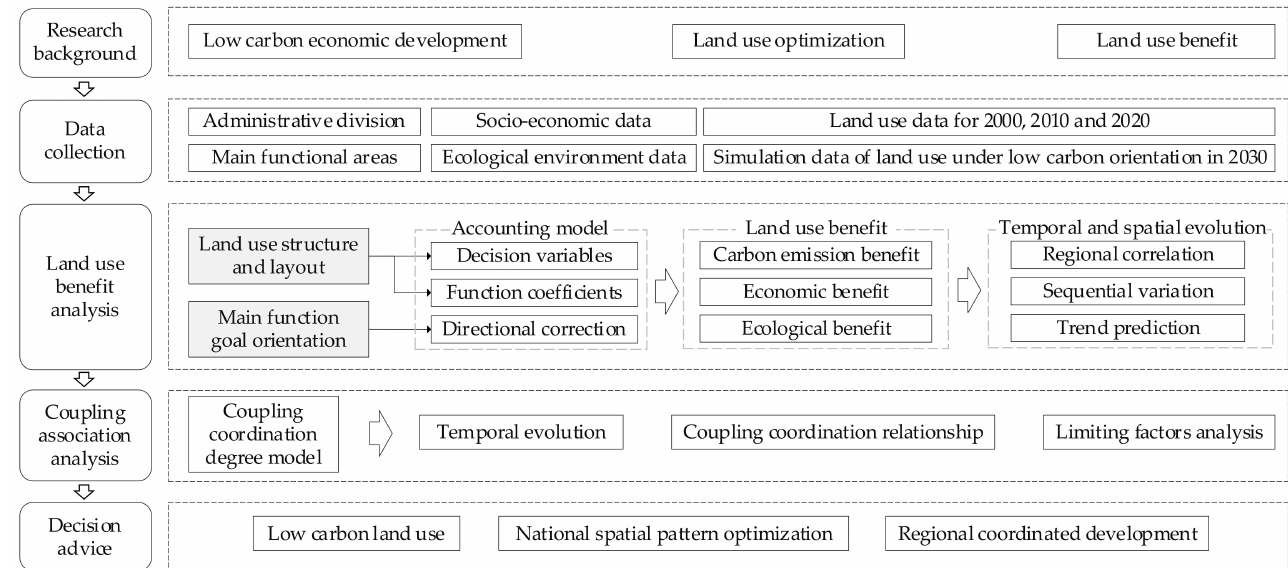
Figure 5. Technical